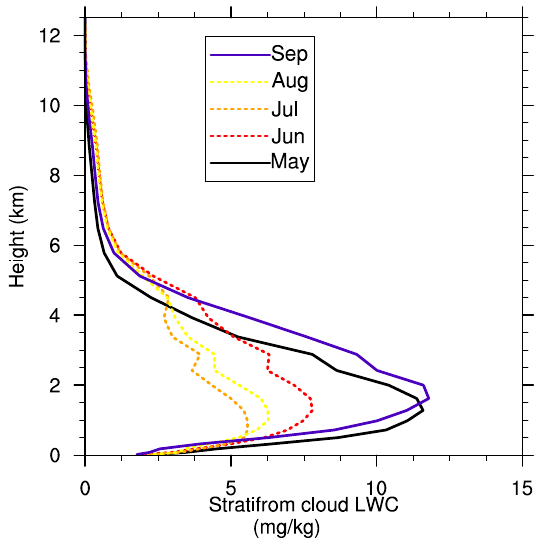
Fig. 7. Vertical profile of liquid water content of stratiform cloud in CONTROL experiment average 20–45 ◦ N, 100–122 ◦ E.